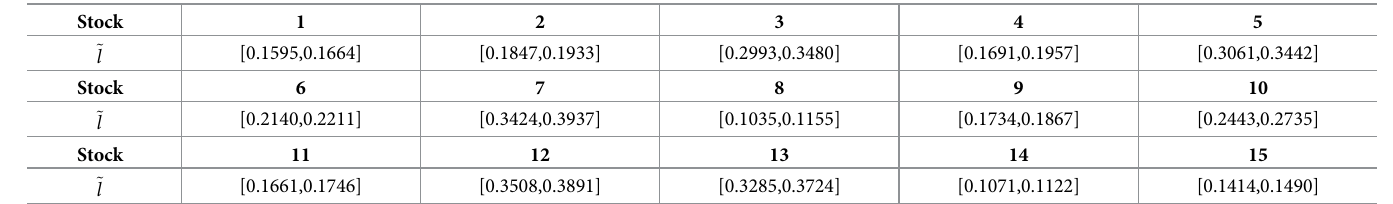
Table 3. The turnover rate